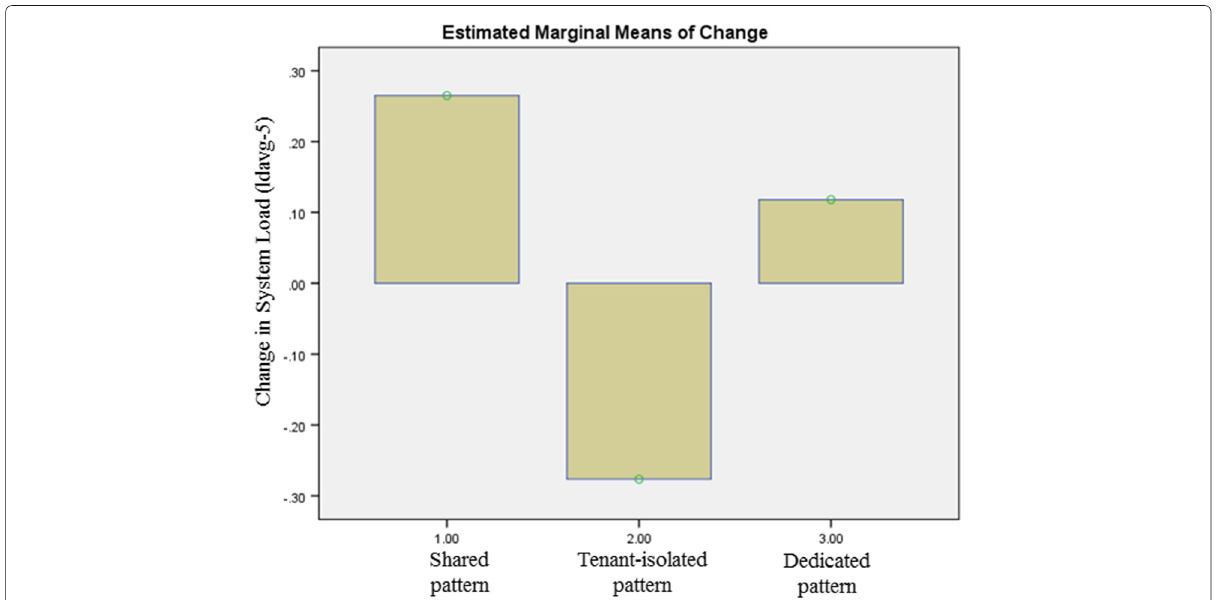
Fig. 21 Changes in System Load [CS2]